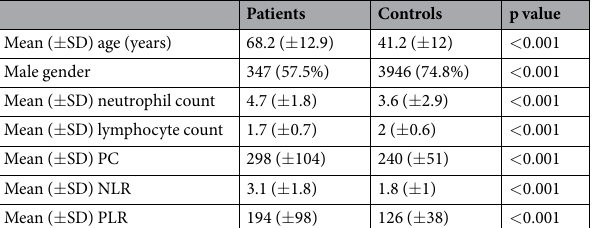
optimal cut-off values were identified: 3.5 for NLR (i.e. low [L]-NLR ≤ 3.5 and high [H]-NLR > 3.5), 350 for PLR (i.e. low [L]-PLR ≤ 350 and high [H]-PLR > 350) and 350 × 10 9 /L for PC (i.e. low [L]-PC ≤ 350 × 10 9 /L and high [H]-PC > 350 × 10 9 /L), respectively (see Supplementary Fig. S1). According to these thresholds, increased values were observed in 26.2% of CRC cases versus 3.2% of the controls for NLR, 6.8% of cases versus 0.0004% of con- trols for PLR, and 24.9% of cases versus 2.7% of controls for PC (all p < 0.001). Correlation between NLR, PLR and PC and clinicopathological variables. The correlations of NLR, PLR and PC with clinicopathological variables are shown in Table 2. H-NLR was more frequently observed in patients with increased age (p = 0.026), advanced pT (p < 0.001), TNM stage tumours (p < 0.001), metastatic disease (p < 0.001) and CEA positive cancers (p = 0.017). H-PLR was observed more frequently in advanced pT